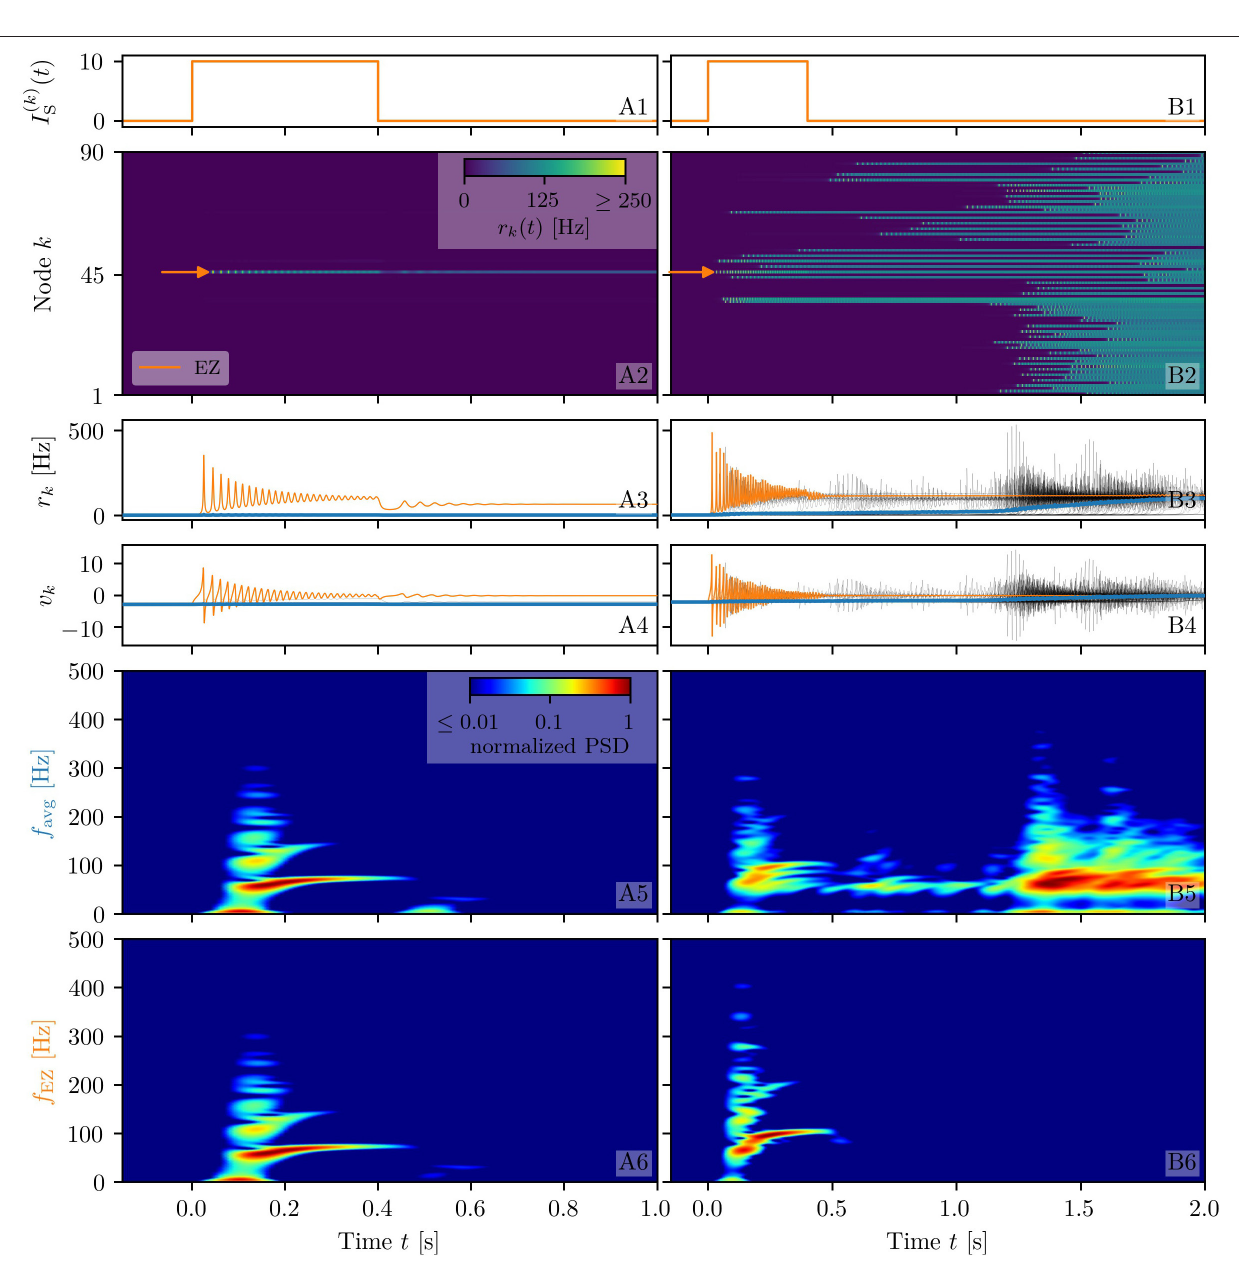
η ( k ) η 9.54, ¯ = ¯ = − 90, τ m 20 ms, 1 1, = = =